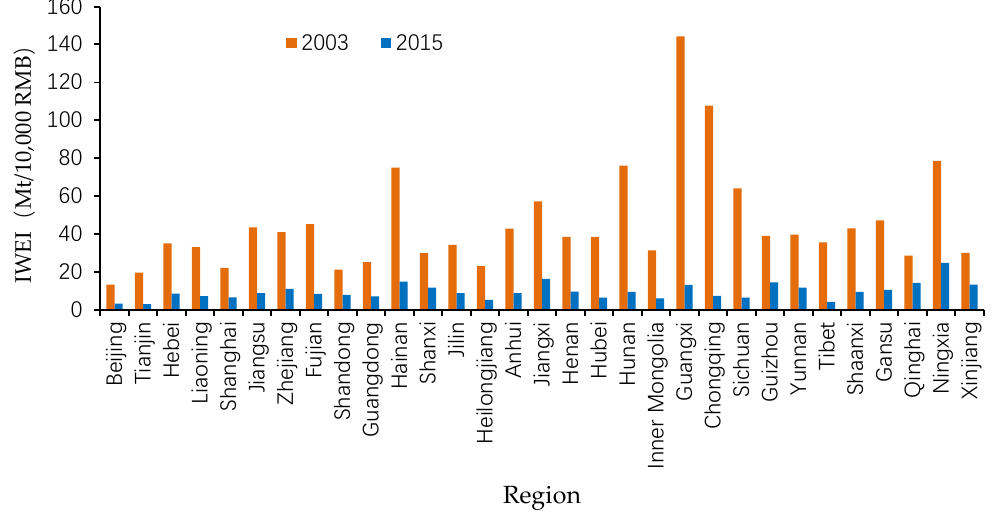
Figure 1. China’s regional industrial wastewater emission intensity, 2003–2015. Data resources: Annual Statistic Report on Environment in China [16]. IWEI: Industrial wastewater emission intensity.